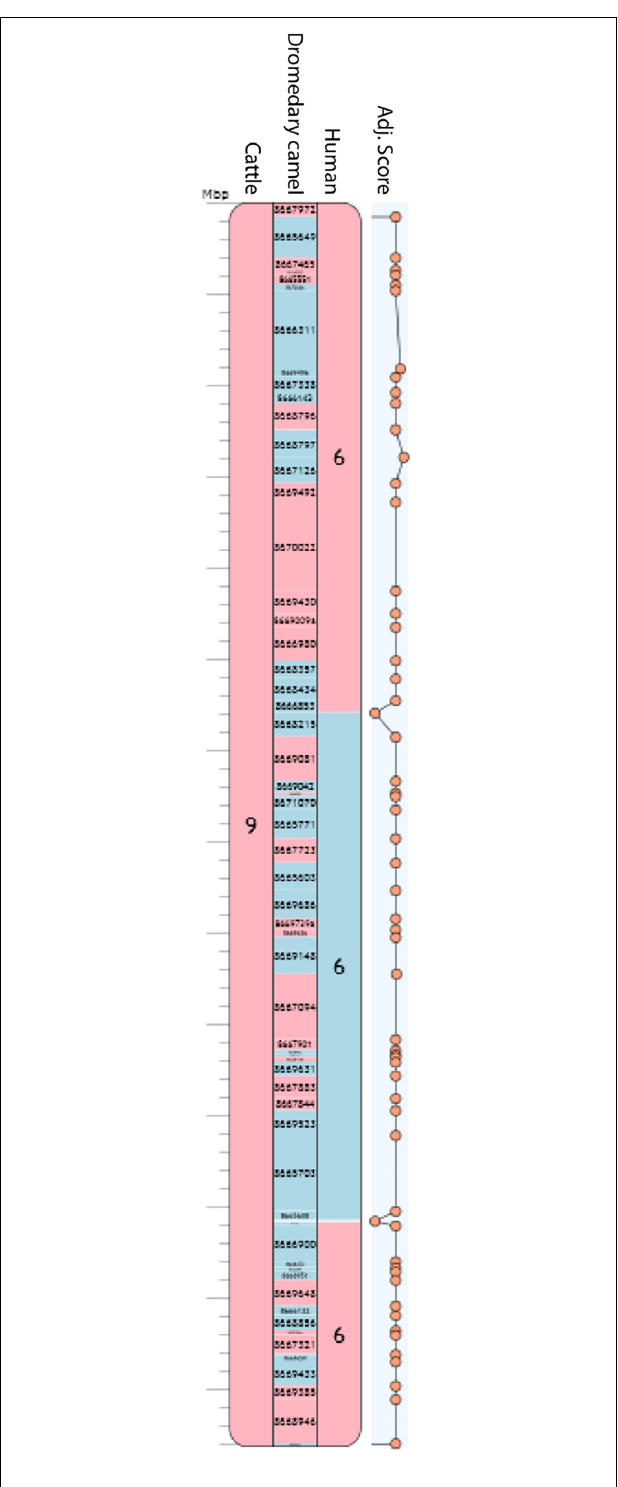
Frontiers in Genetics |